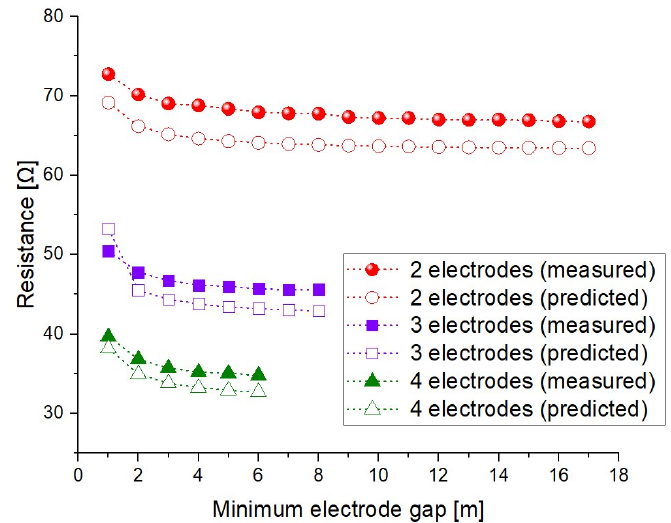
Figure 11. Measured and predicted resistances of electrodes connected in